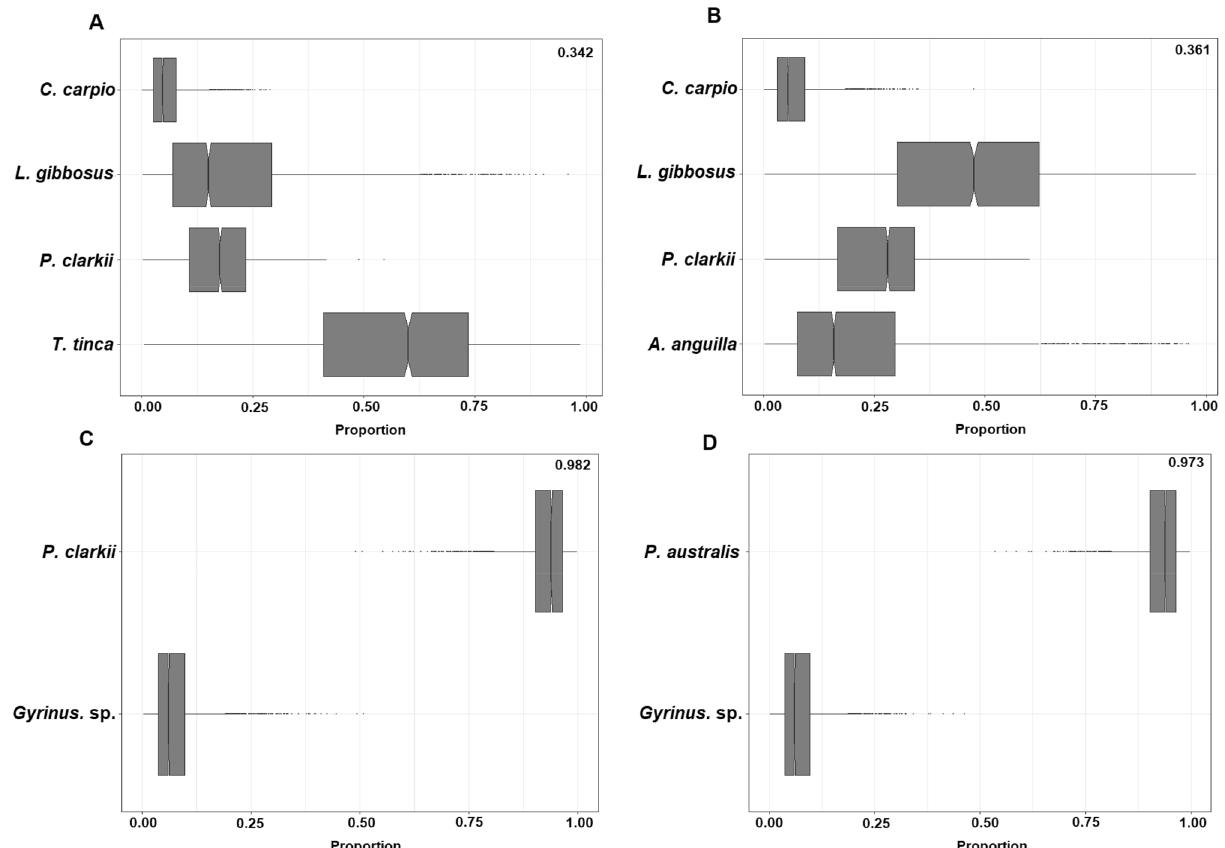
Figure 2.. Mixing models estimated for the respective predatory species: ( A ) Micropterus salmoides and, Tinca tinca as potentially available prey; ( B ) Micropterus salmoides under the assumption of present A. anguilla ; ( C ) Lepomis gibbosus assuming that Gyrinus sp. is present in Arreo Lake; and ( D ) Procambarus clarkii under the assumption of present Gyrinus sp.. Numbers in the upper right corner indicate the estimated probability of the presented prey contribution to the respective predators’ isotopic